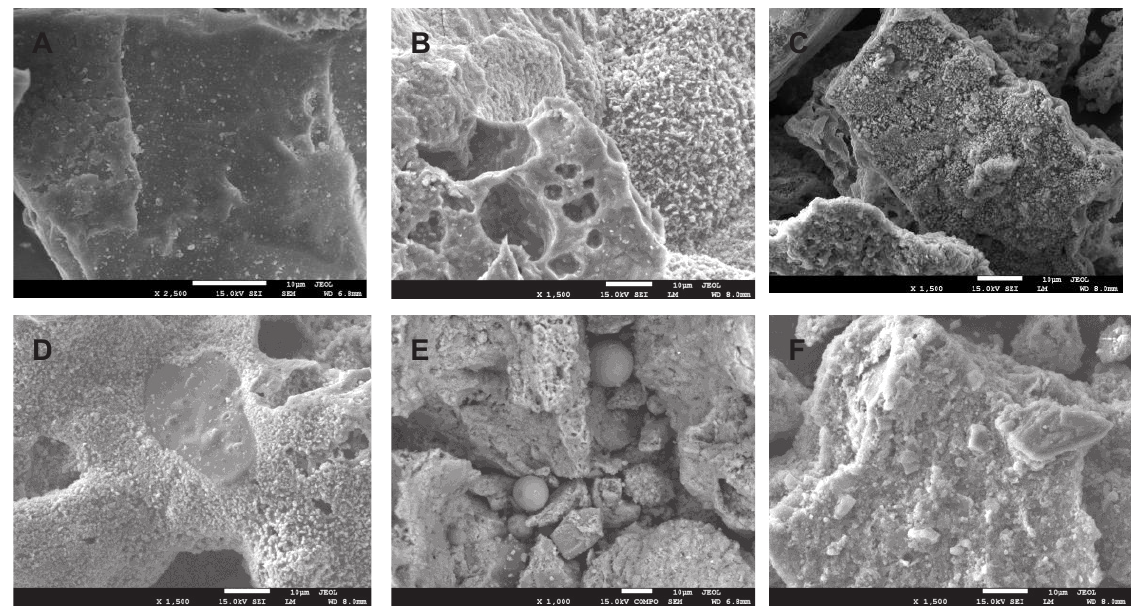
Figure 1: Scanning electron micrographs of SSA: A-Szczecin Slag, B-Szczecin Dust, C-Kielce, D-Kraków, E- Warszawa, F- Łódź.